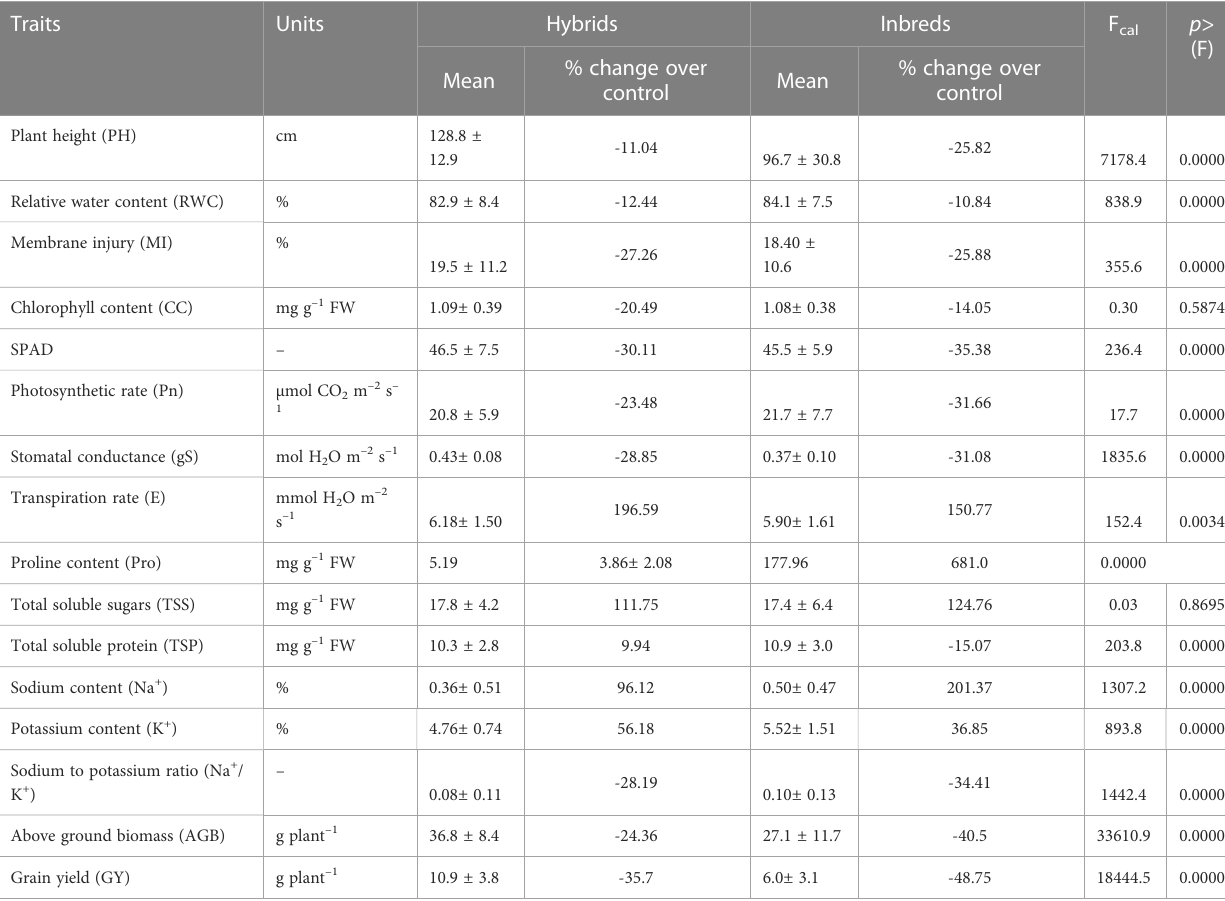
TABLE 2 Effects of salinity stress on various traits in pearl millet hybrids and inbreds through group comparison analysis (averaged across 7 hybrids and 10 inbred lines). Traits